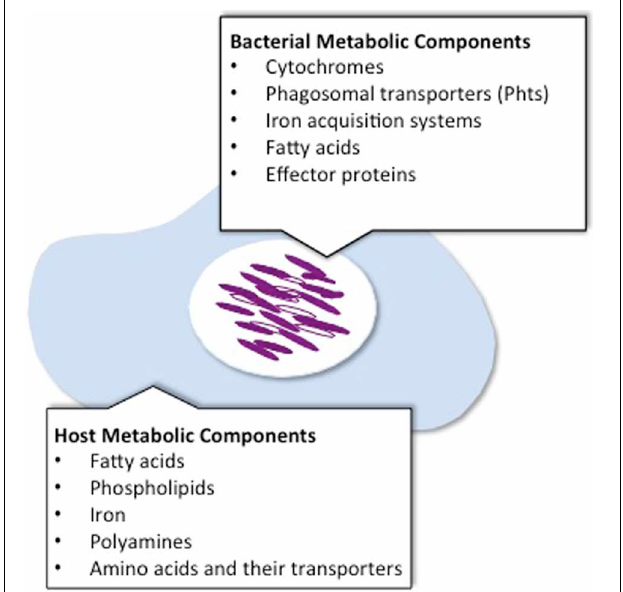
FIGURE 2 | Metabolic components known to be exploited by L. pneumophila for intracellular replication. To replicate within host cells, L. pneumophila exploits metabolic components that may originate from the bacteria or the